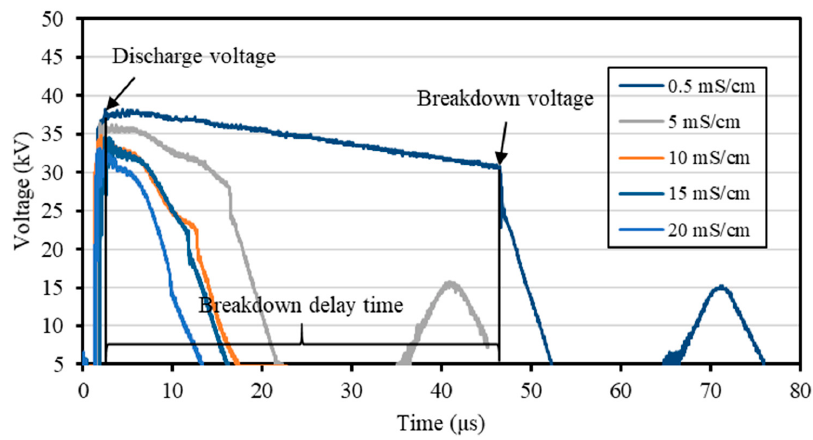
Figure 5. Voltage waveforms under the electrical conductivity from 0.5 mS/cm to 20 mS/cm.